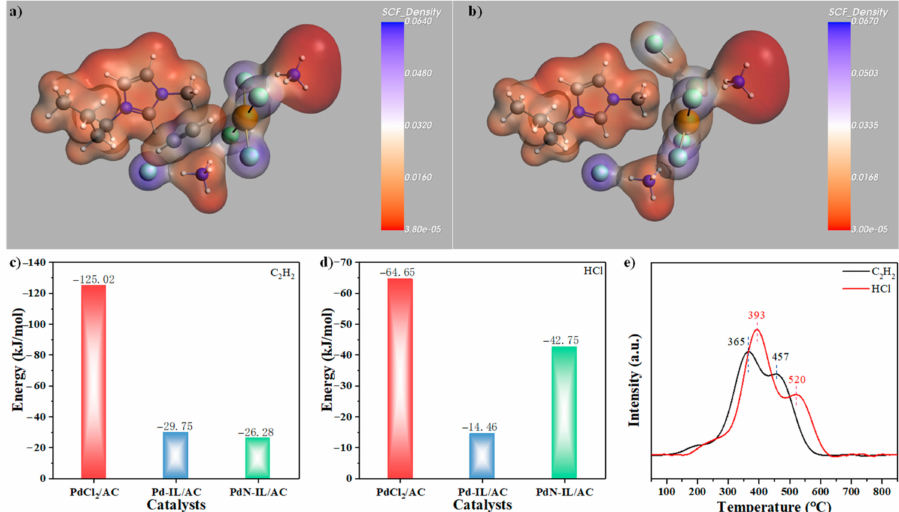
Figure 7. DFT calculations on the activation mechanism. The optimal structures of Pd-A-IL / AC catalyst with ( a ) C 2 H 2 and ( b ) HCl adsorbed. The adsorption energies of ( c ) C 2 H 2 and ( d ) HCl. ( e ) TPD profiles of C 2 H 2 and